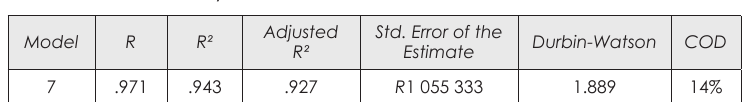
Summary of statistical indicators, Model